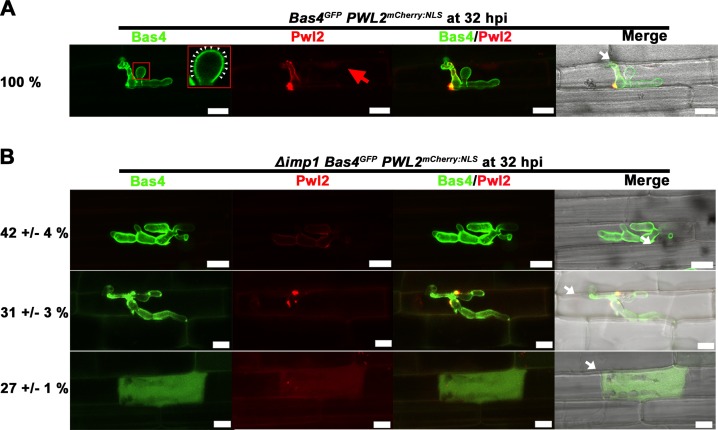
IMP1 maintains biotrophic interface integrity.WT (A) and Δimp1 (B) strains expressing the fluorescently labeled apoplastic effector Bas4GFP and the fluorescent BIC-accumulating cytoplasmic effector Pwl2mCherry:NLS at 32 hpi. White arrows indicate appressoria on the leaf sheath surface and red arrow indicates the faint enrichment of Pwl2mCherry:NLS in an adjacent rice nucleus. Arrowheads highlight Bas4GFP in the apoplast. Scale bars = 10 μm. Percentages are mean values +/- s.d. of each representative image obtained from observing 100 infected rice cells per strain, repeated in triplicate.